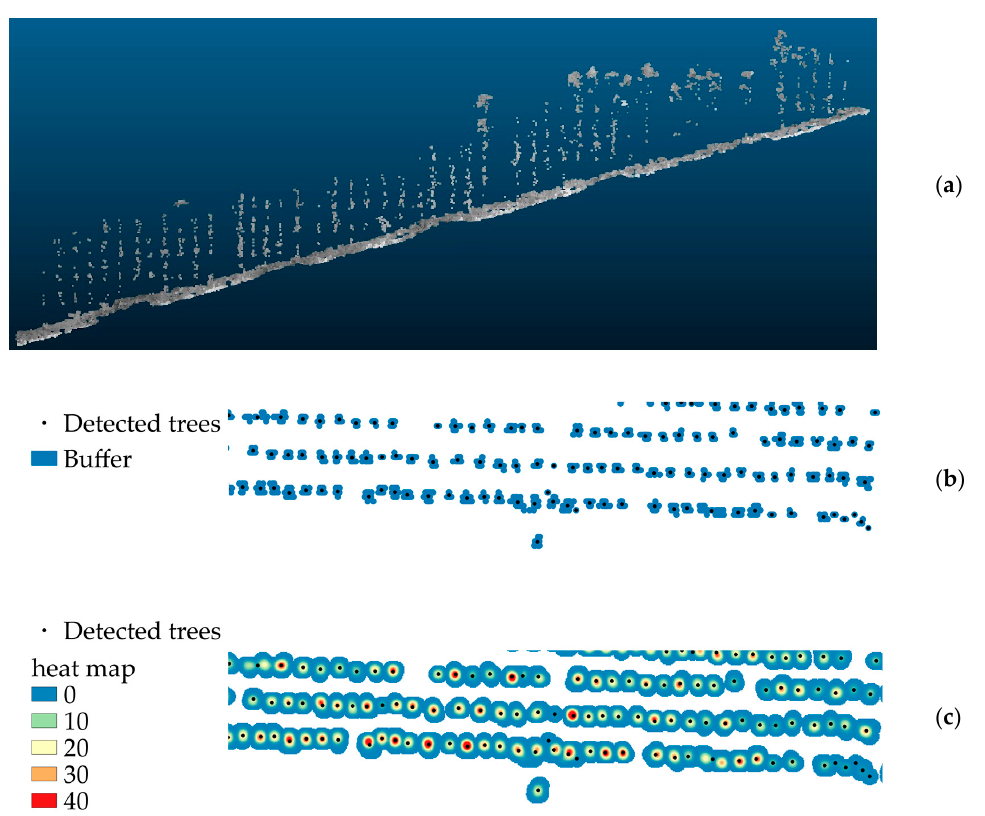
Figure 7. Overview of the individual tree detection (ITD) results obtained by Method 1 and Method 2: ( a ) point cloud of a sample row of trees; ( b ) bu ff ering on the horizontal projection of the points and the located individual; ( c ) standardized density raster on the horizontal projection of the points and the located